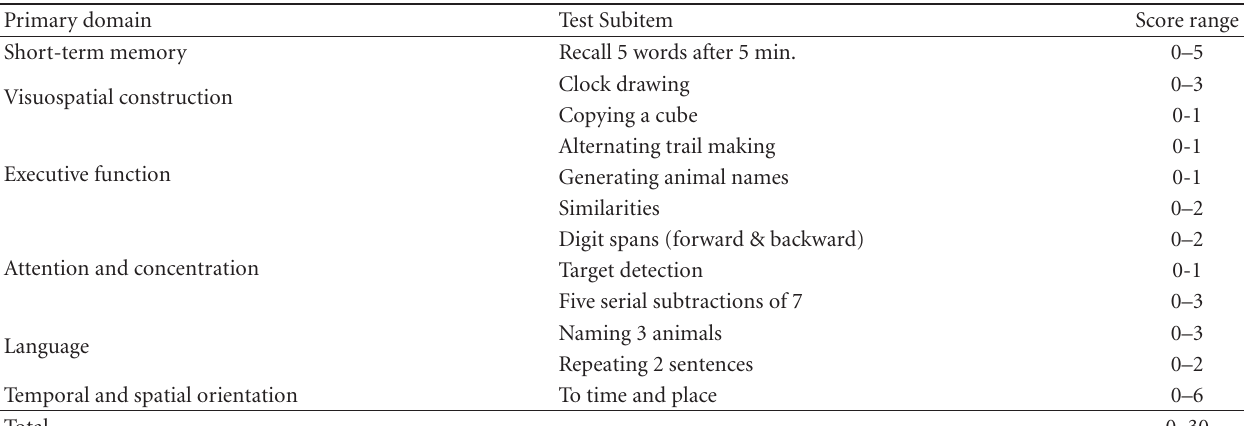
Table 1: MoCA-ChLA domains and